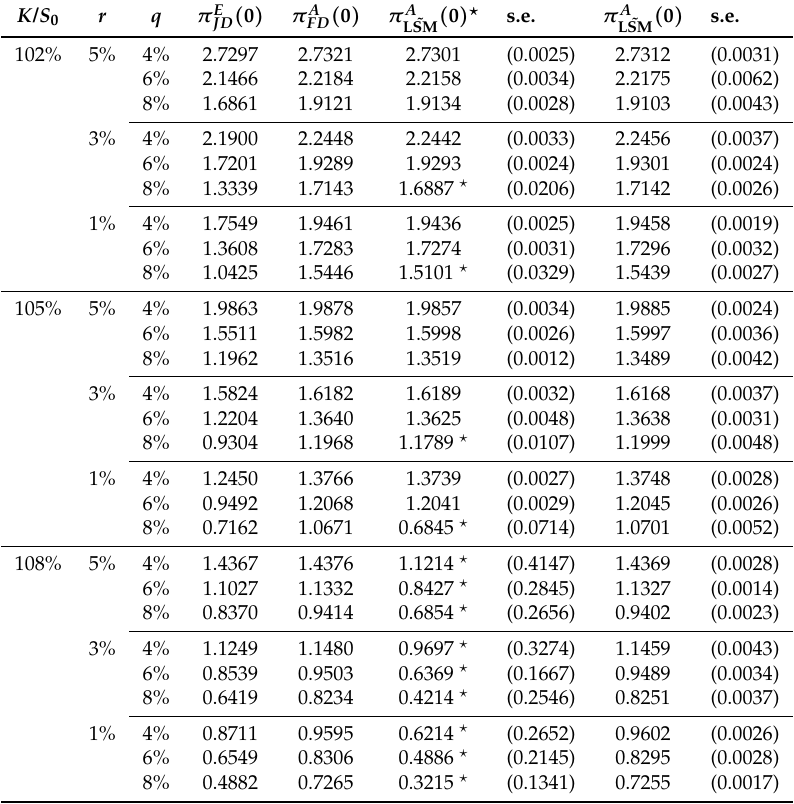
Table 3. Numerical results, jump-diffusion. S 0 = 100, T = 1, σ = 10%, a = 0, b = 1%, λ = 1;